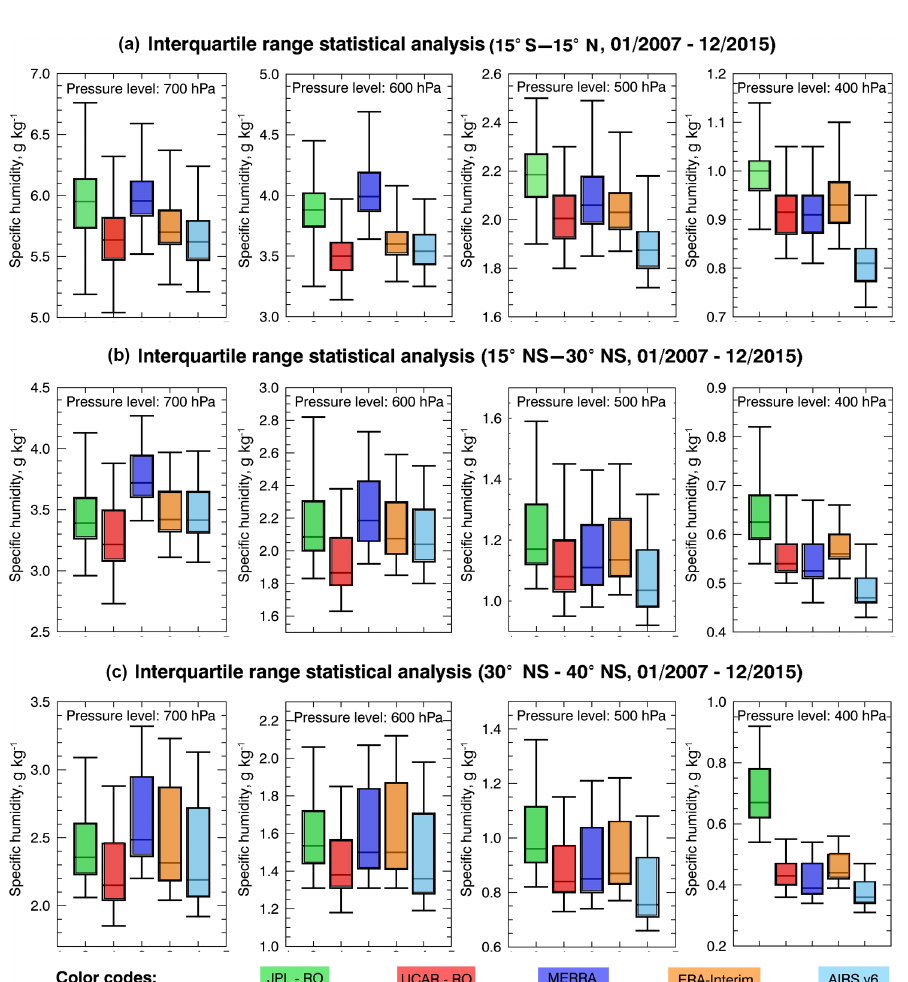
Figure 3. Box plots of the monthly zonal mean specific humidity throughout the 2007–2015 time period for the 700, 600, 500, and 400hPa over the ascending branch of Hadley cell ( ± 15 ◦ ) (a) , the trade winds belt ( ± 15–30 ◦ NS) (b) , and the descending branch of Hadley cell at the subtropics ( ± 30–40 ◦ ) from JPL (green), UCAR (red), MERRA (blue), ERA-Interim (orange), and AIRS